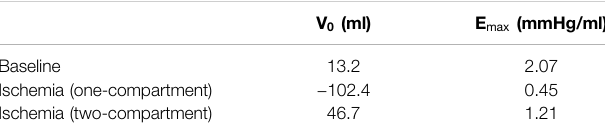
TABLE 1 | Characteristics oftheleft ventricular (LV)end-systolicpressure – volume relation